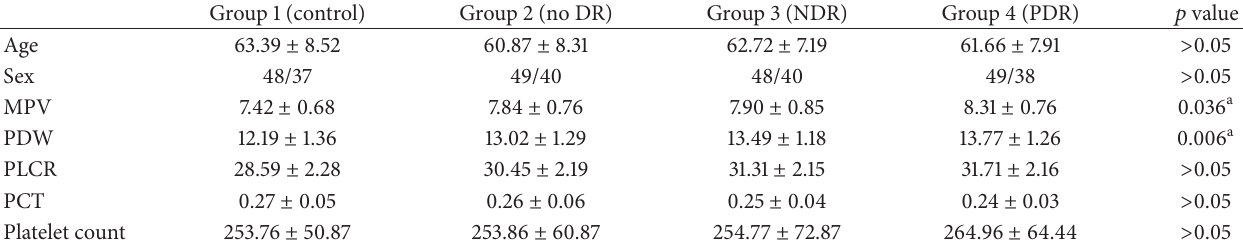
Table 1: Demographic data and comparison of platelet parameters (mean ± SD) for the four study